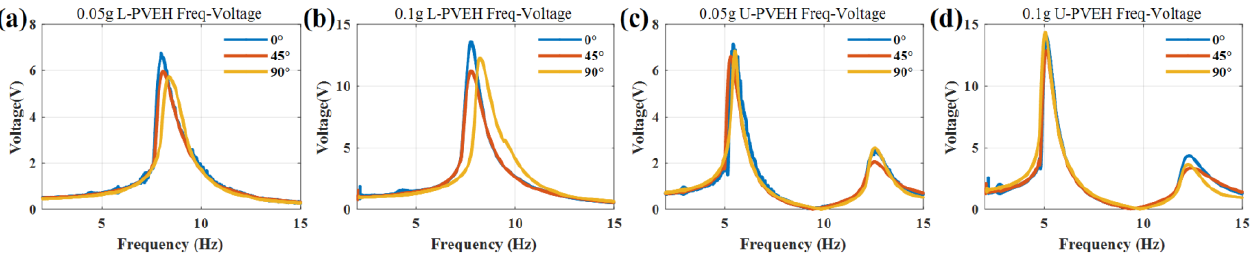
Figure 6. Experimental voltage frequency response curves with different gravity angles: the L- shaped PVEH at an acceleration of ( a ) 0.05 g and ( b ) 0.1 g; the U-shaped PVEH at an acceleration of ( c ) 0.05 g and ( d ) 0.1 g.